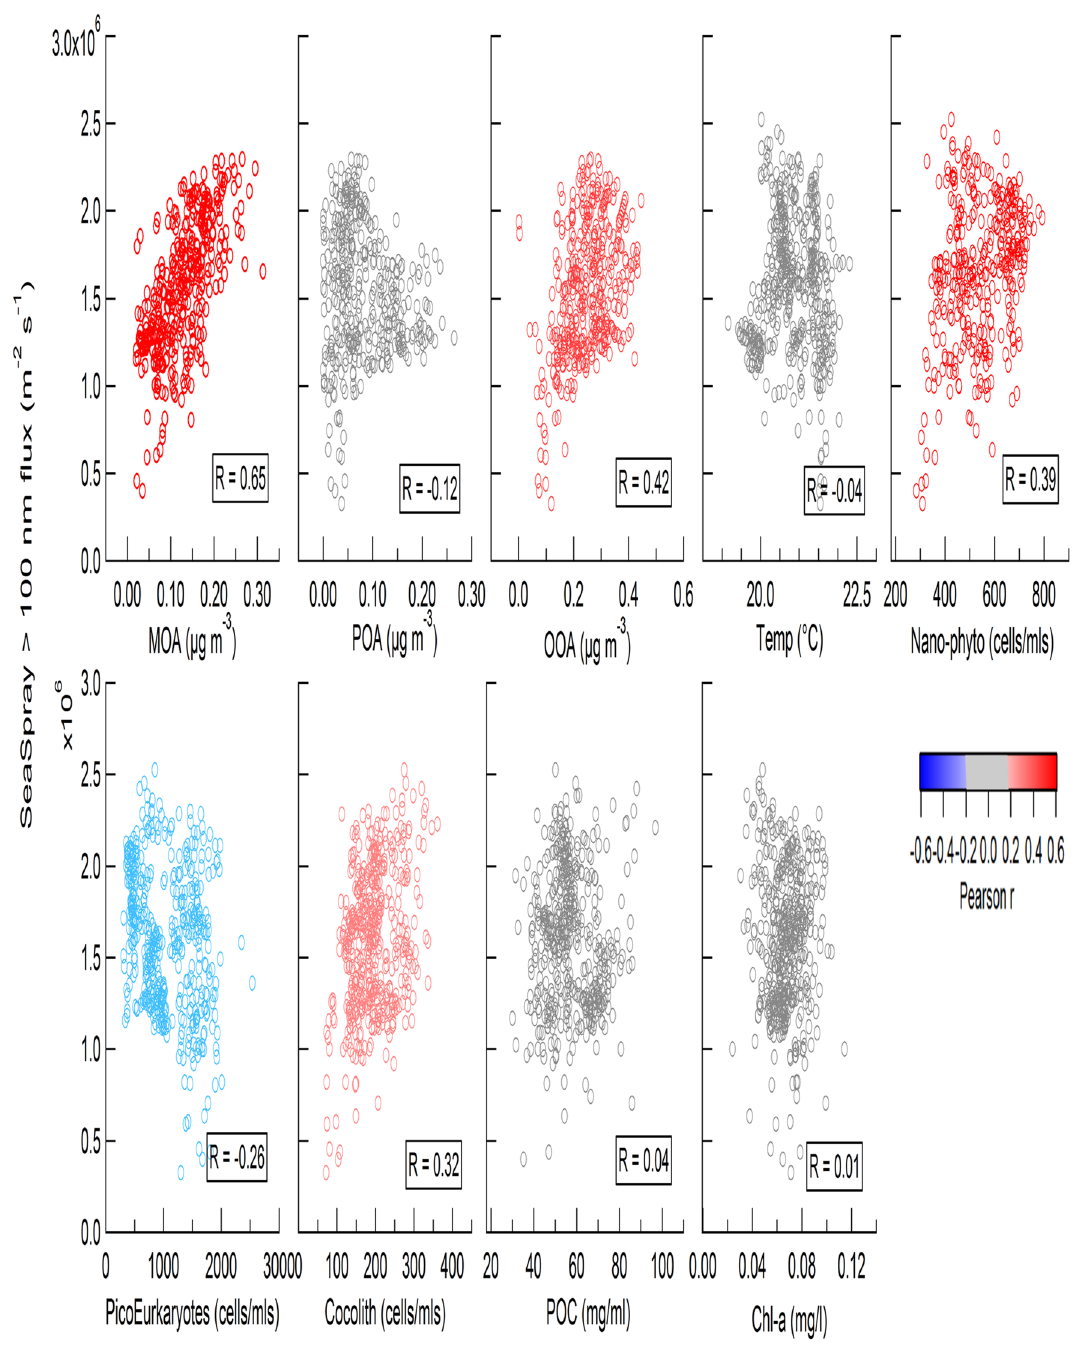
Figure 2. Correlation plots between the sea spray larger than 100 nm number fluxes (m −2 cm −1 ) and the three classes of organic matter in nascent sea spray (MOA, POA, OOA), Sea Surface Temperature (SST, °C), seawater cell abundances (cells ml −1 ) for nanoeukaryotes (2–20 µm size; NanoPhyto ), picoplankton (3 µm or less in size), coccolithophore-like cells, particulate organic carbon (POC, mg ml -1 ), and total surface Chl- a (µg l −1 ), from the Mediterranean cruise data set. Red datapoints indicate a significant positive correlation, Blue a significant negative correlation and grey no significant relationship at the 99.9% confidence